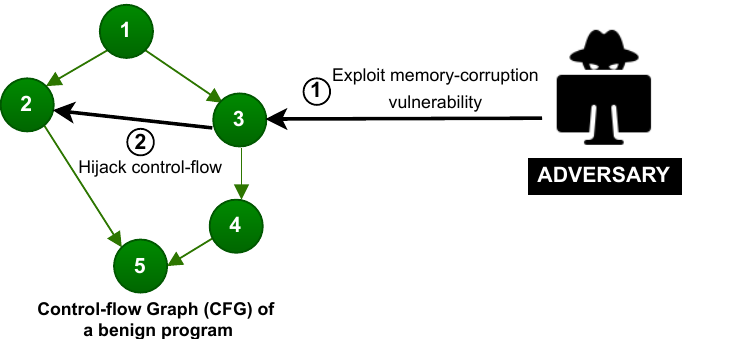
Figure 2. Code-reuse attack. The Control Flow Graph (CFG) represents the legitimate execution flows of a benign software, where each graph node (Nodes 1–5) denotes a software instruction. A code-reuse adversary performs the actions 1–2.